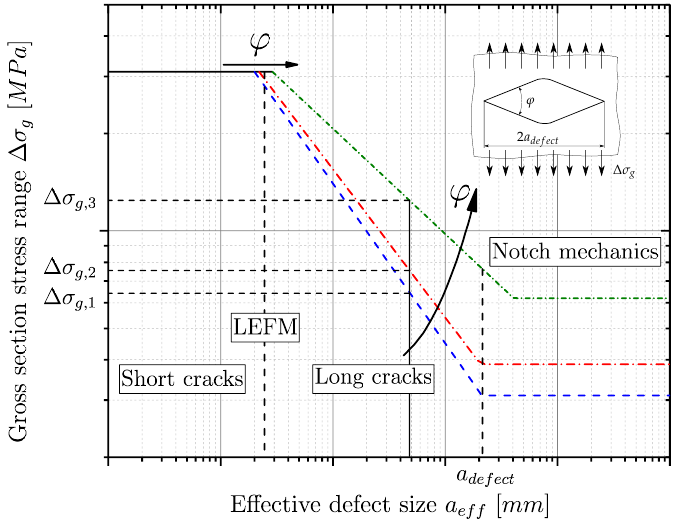
Figure 1. Schematic structure of a generalized Kitagawa diagram